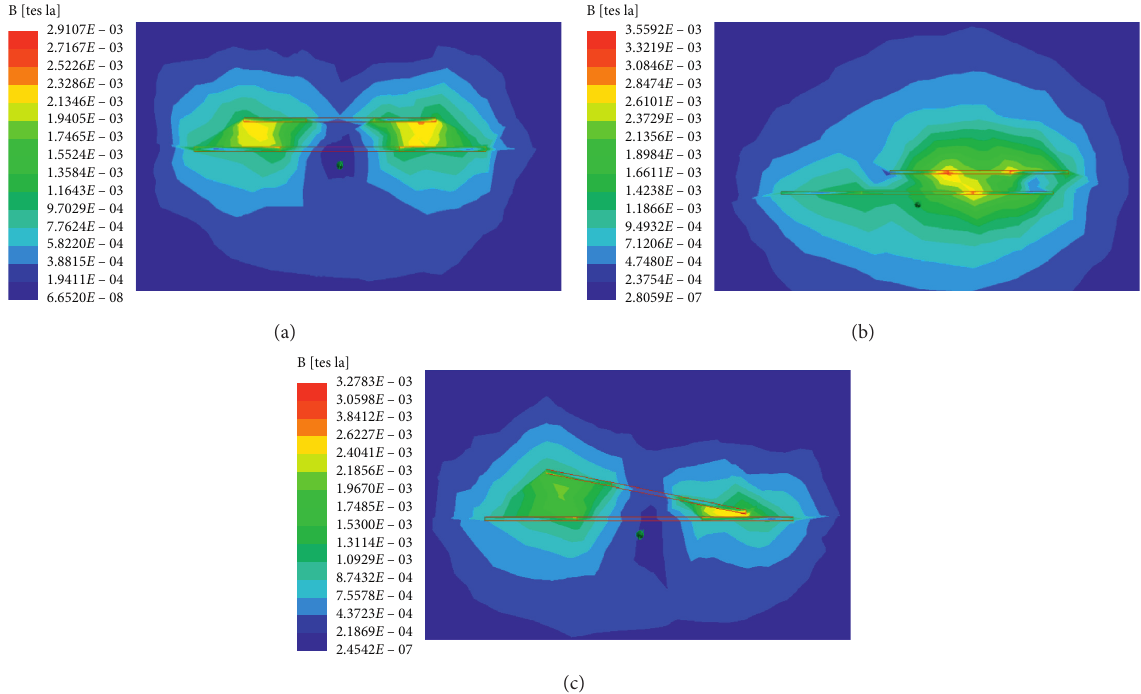
Figure 8: Magnetic field distribution of the coil at different relative positions. (a) Magnetic field distribution of the coil coaxial and parallel. (b) Magnetic field distribution of coil with horizontal offset of 100mm. (c) Magnetic field distribution of coil angle inclined 10 ° .